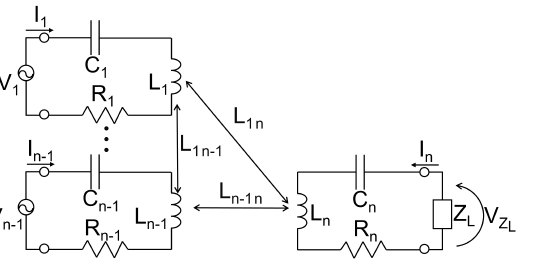
Figure 2. Equivalent circuit of wireless power transfer via magnetic resonance coupling (MRC-WPT) using phased array transmission (Tx) coils. Since the magnetic field at the position of the interfering object was assumed to be suppressed, their effect was ignored